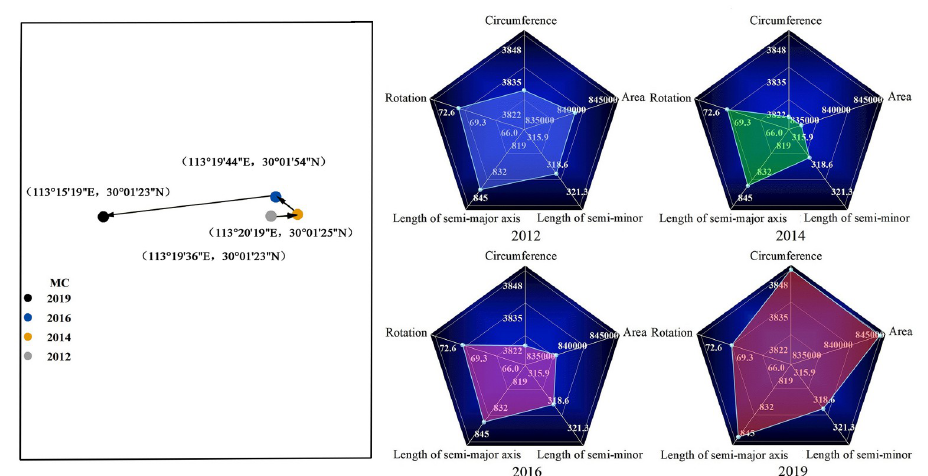
Fig 6. The changes of relevant parameters of SDE.